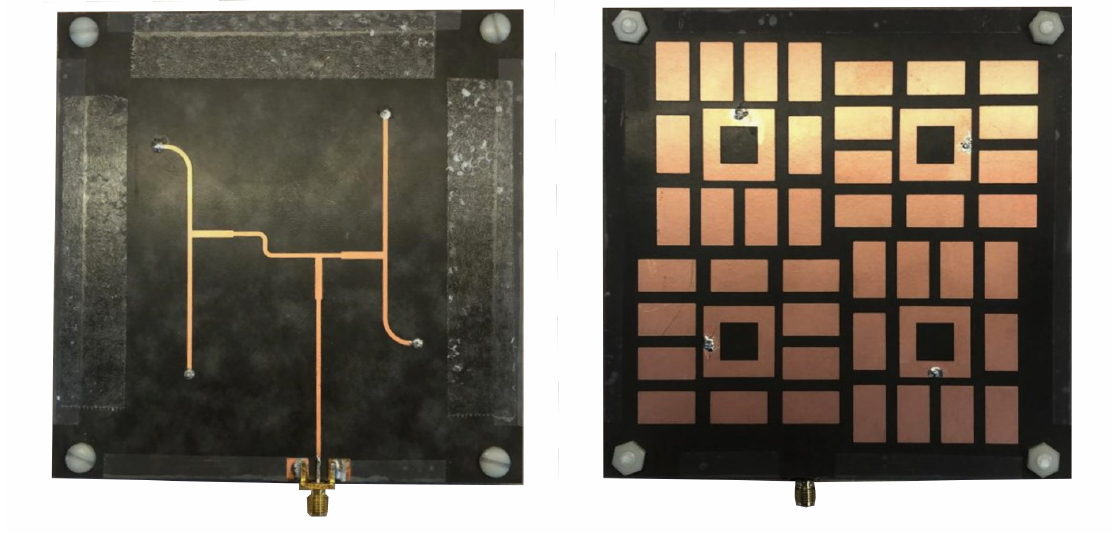
Figure 7. Top and bottom views of the fabricated prototype of the 2 × 2 RWMS array incorporated with the feed network.